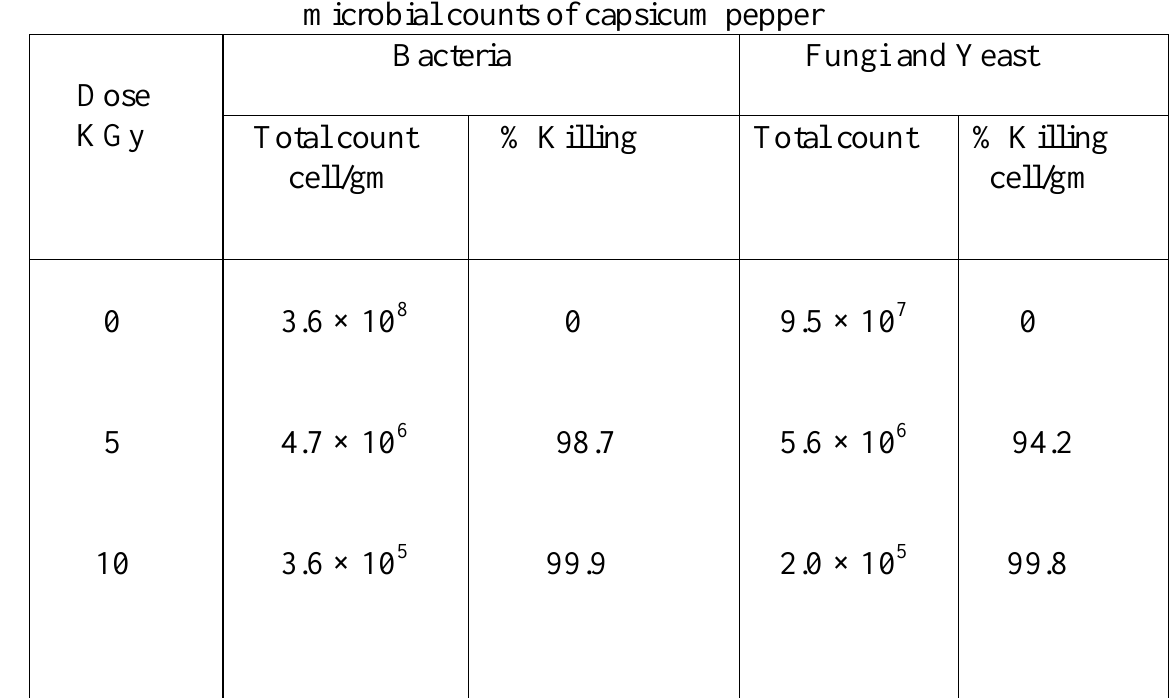
Table (1): Effects of 5KGy and 10KGy gamma radiation on total